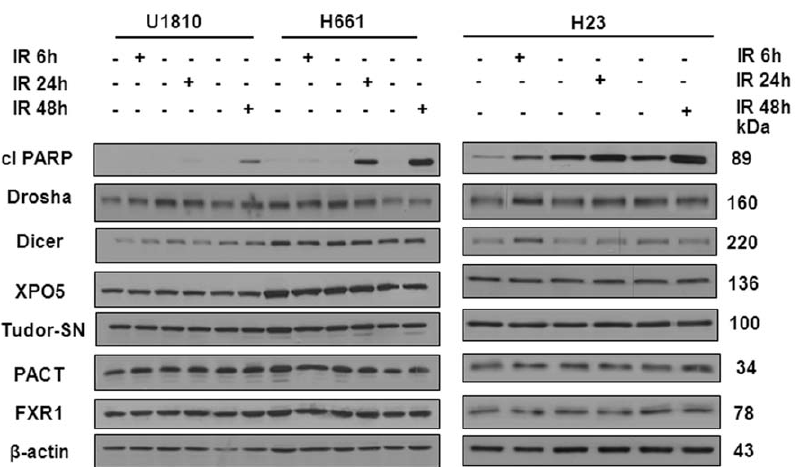
Figure 2. Expression of components of miRNA machinery in NSCLC following treatment with ionizing radiation. The cleavage of PARP and the level of expression of Drosha, Dicer, exportin 5 (XPO5), Tudor-SN (TSN), protein activator of the interferon-induced protein kinase (PACT), and fragile X mental retardation syndrome-related protein 1 (FXR1) in U1810, H661 and H23 cells were detected by Western blot at 6, 24 and 48 h post- irradiation with 8 Gy. Equal loading was verified using anti- b -actin antibodies. Data are representative of three independent experiments.